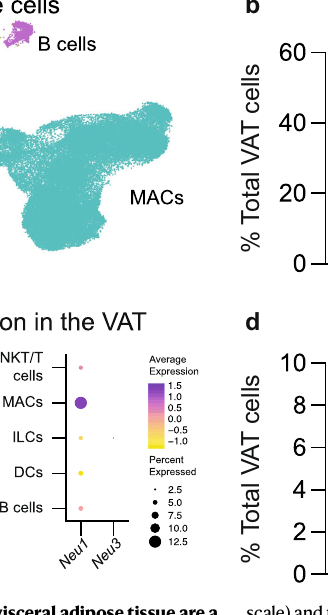
Fig.5| Neu1- expressingmacrophagesinthemousevisceraladiposetissuearea potential source of NANA. a Cellular landscape of the mouse visceral adipose tissue (VAT) immune cells across all genotype and diet conditions. UMAP embed- ding of single nuclei pro fi les (sNuc-Seq), colored after post hoc cell type annota- tion. Mice from three independent experiments, sample n : WT CD=10, WT HFD=6, 5xFAD CD=9, 5xFAD HFD=13. b HFD increased the frequency of VAT macrophages (MACs). Changes in frequency of the other VAT immune cell types areshown in SupplementaryFig.11e.Annotationsare asinSupplementaryFig.11d, e.Sample n :see a . c Dotplotsfeaturingtheexpressionofsialidase Neu